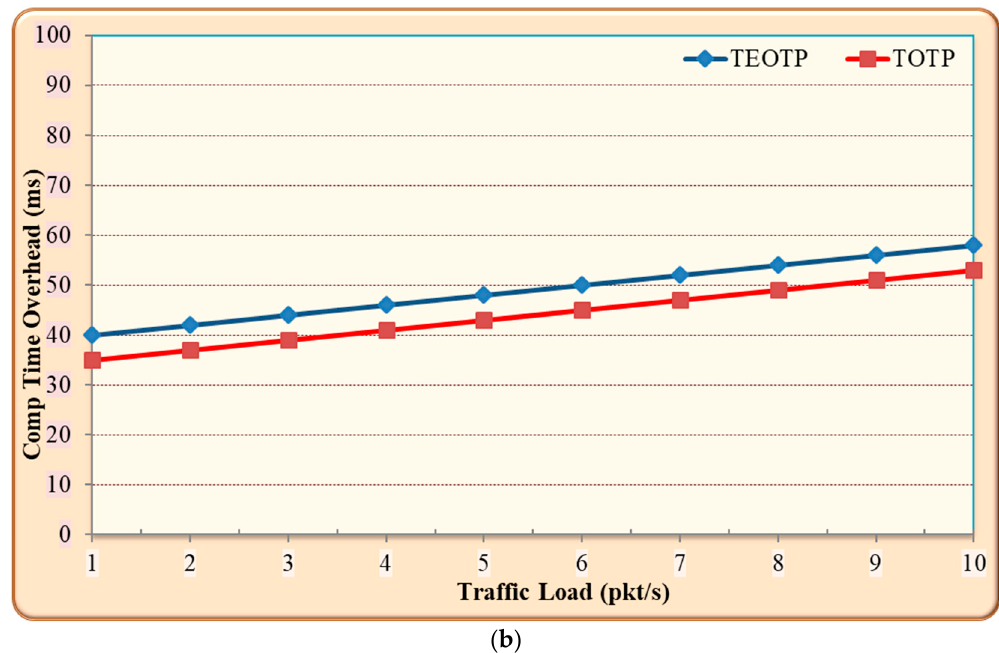
Figure 8. Comparison between the performance of time-enhanced-based one-time password (TEOTP) and time-based one-time password (TOTP): ( a ) authentication failure ratio; ( b ) computation time overhead.